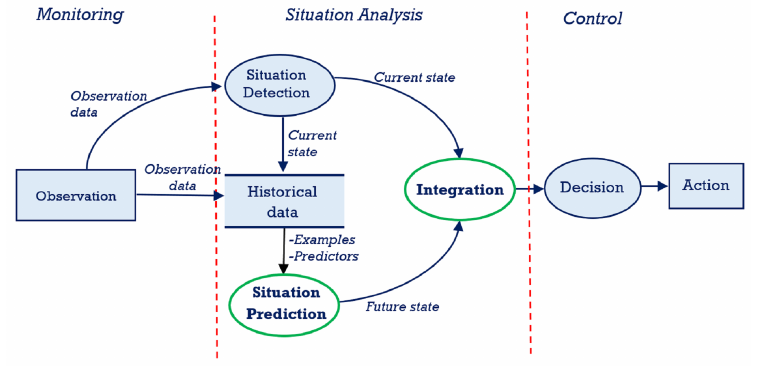
Figure 2. Dataflow diagram of the main components of the proactive